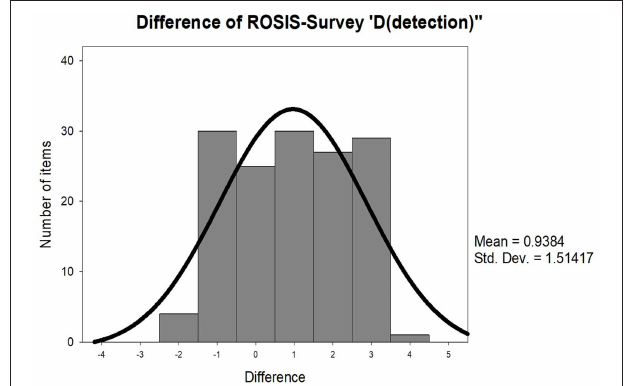
FIGURE 3 | Difference between ROSIS data and expert survey for detectability item.